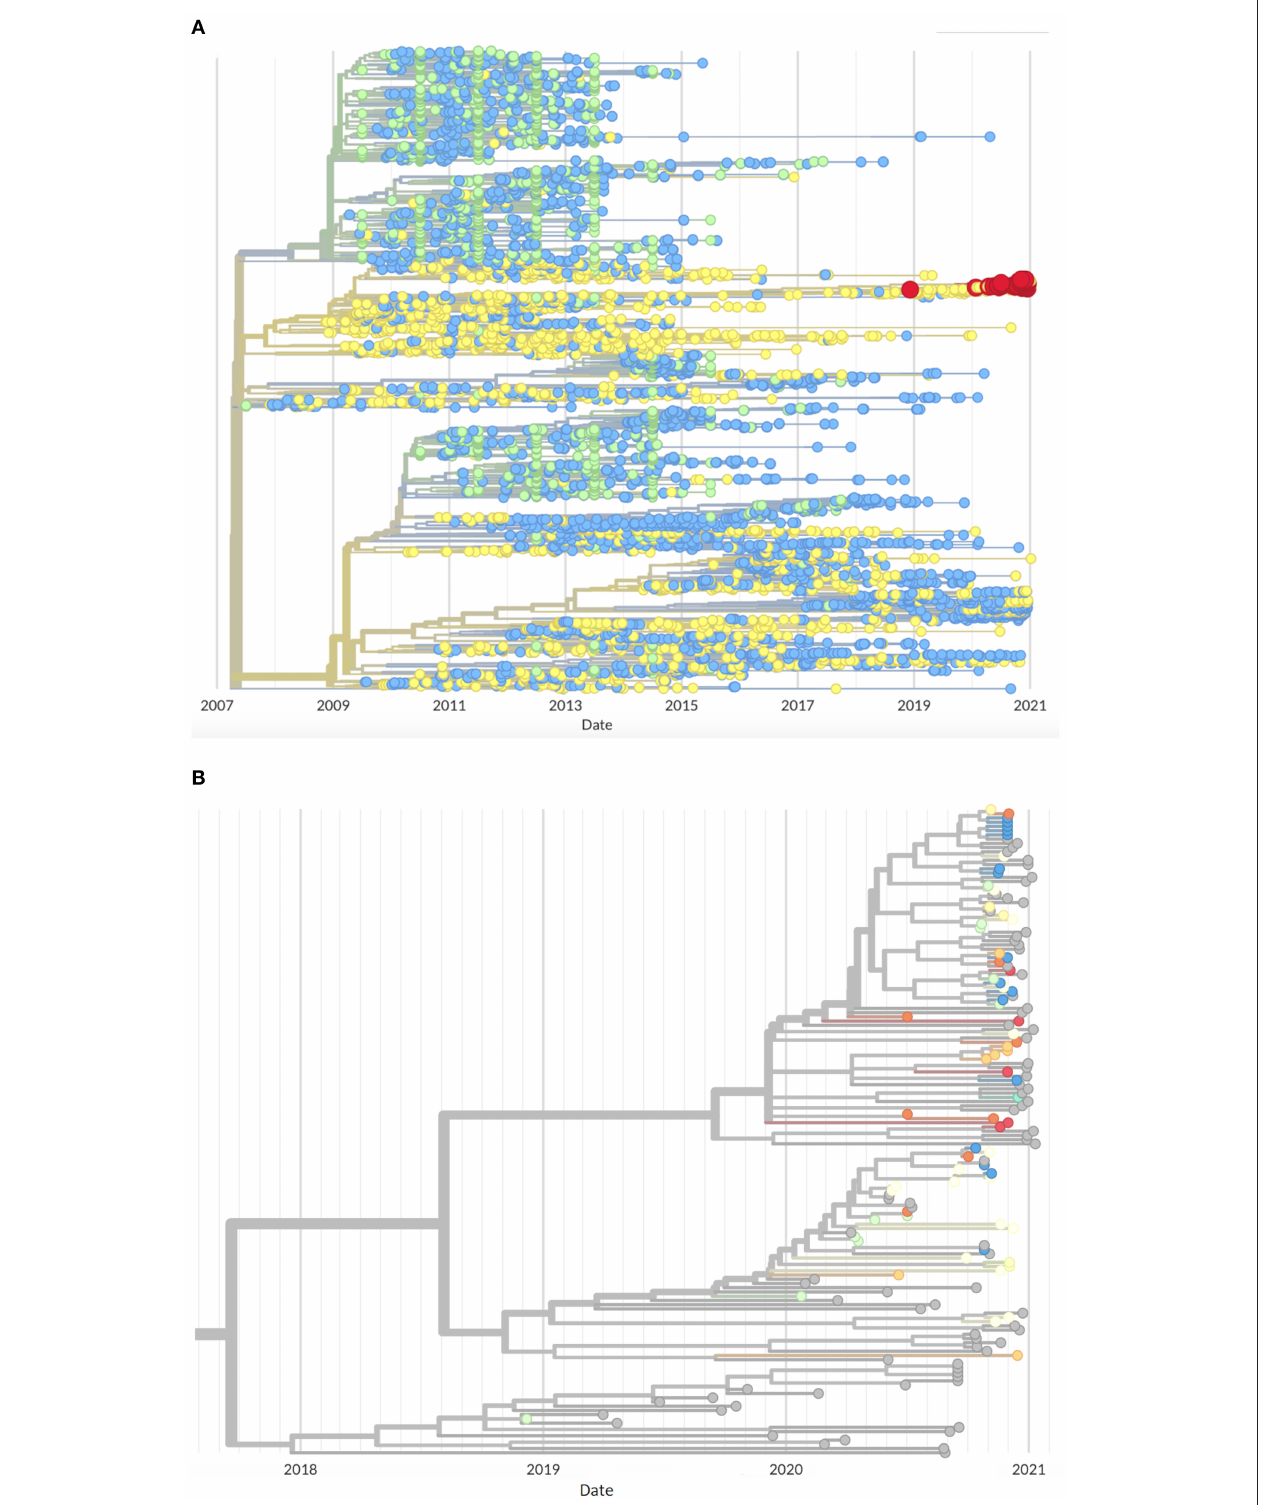
FIGURE 2 | Phylogenetic tree of Lineage 1C orf5 sequences (A) Originating from MSHMP (blue), GenBank (green) and the University of Minnesota Veterinary Diagnostic Lab (yellow) PRRS databases showing the outbreak cases highlighted in red, and (B) Close up of the same tree showing sequences belonging to this outbreak colored by production systems (gray indicates sequences from the University of Minnesota Veterinary Diagnostic Lab PRRS database).